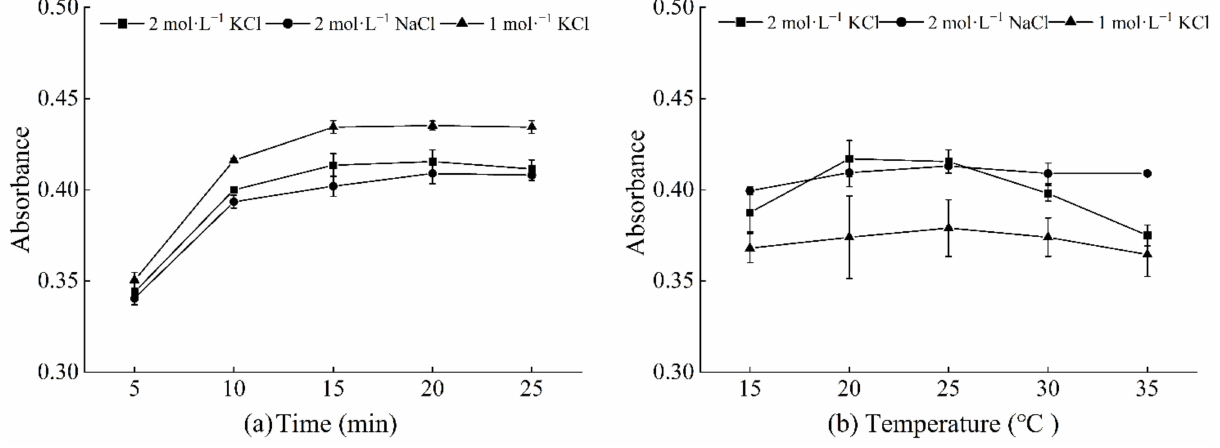
Figure 1. Change in absorbance with color development time ( a ) and temperature ( b